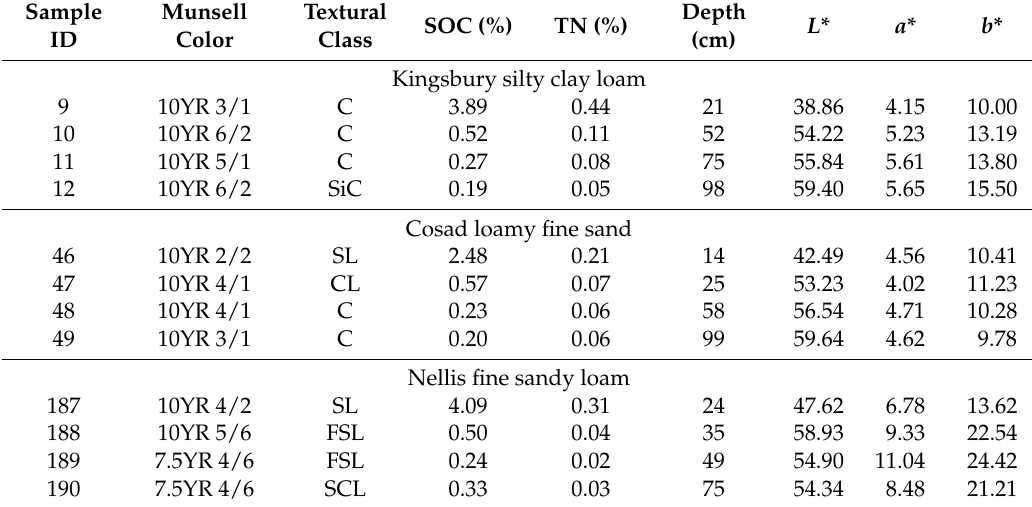
Table 1. Example of selected soil properties for Kingsbury (Alfisols), Cosad (Entisols), and Nellis (Inceptisols) soil